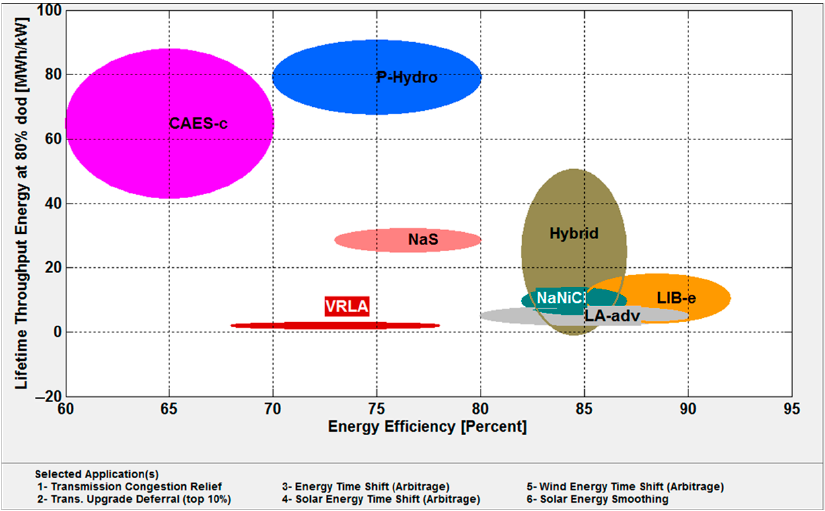
Figure 9. Lifetime throughput Energy at 80% dod (MWh/kW) as a function of efficiency (%) for different types of ESSs.